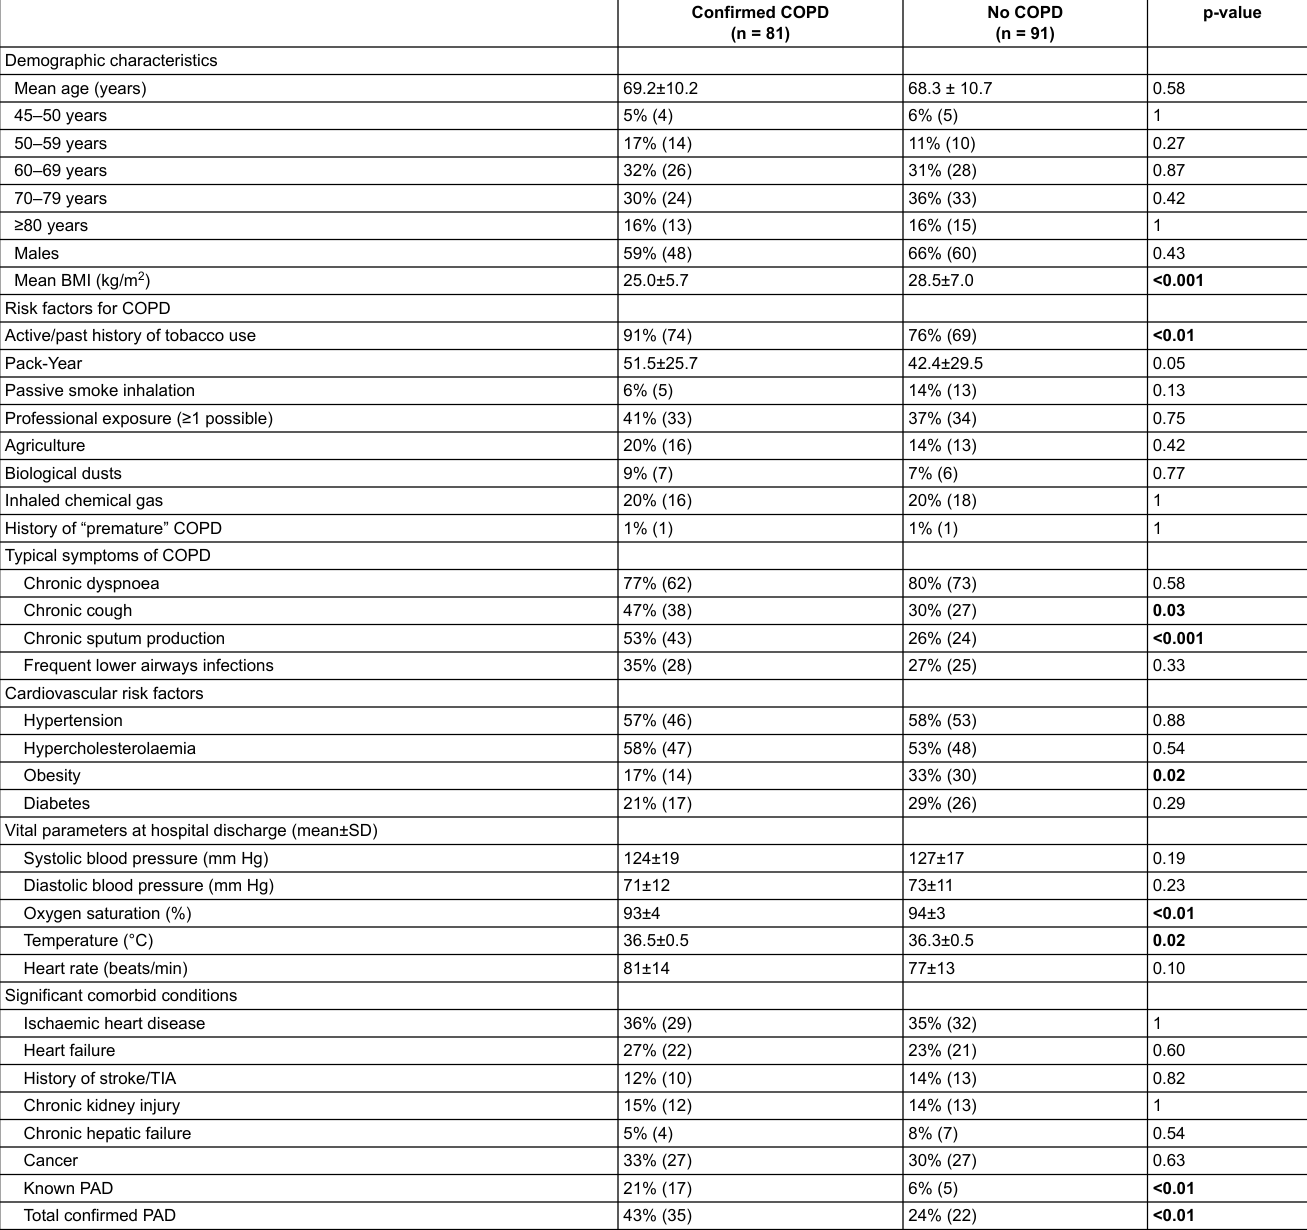
Table 3: Characteristics of patients with confirmed chronic obstructive pulmonary disease (COPD) vs no